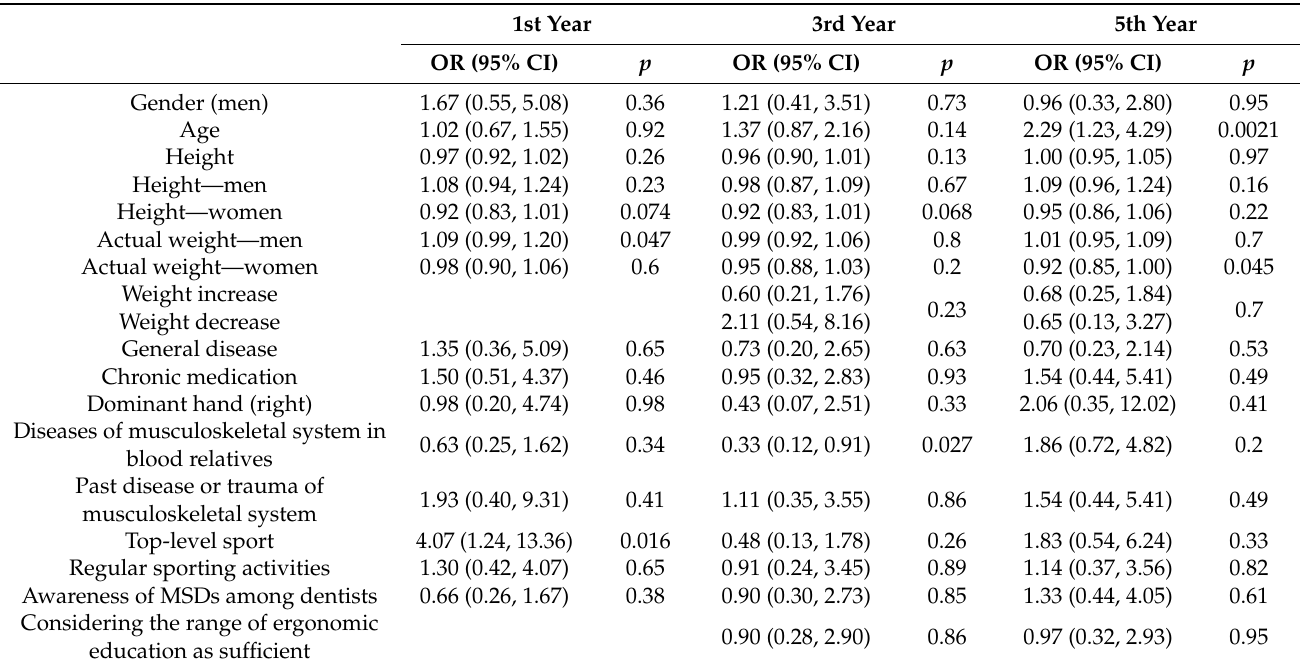
Table 3. The univariate analysis of the influence of the followed factors on the occurrence of lower back